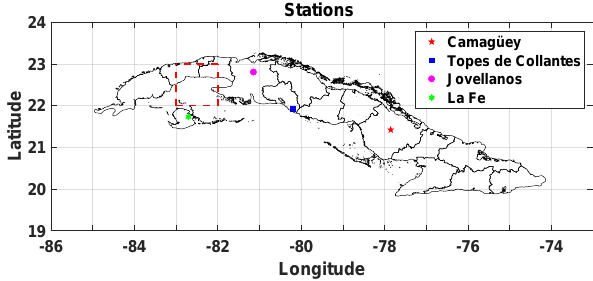
Table 1. Aerosol products from the MODIS Collection 6 data set used in the present study. Product Description Deep_Blue_Aerosol_Optical_Depth_550_ Deep blue AOT at 0.55 micron for land with higher Land_Best_Estimate quality data (quality flag = 2, 3) Deep_Blue_Angstrom_Exponent_Land Deep blue Ångström exponent for land with all quality data (quality flag = 1, 2, 3) Optical_Depth_Land_And_Ocean AOT at 0.55 micron for both ocean (average) (quality flag = 1, 2, 3) and land (corrected) (quality flag = 3)